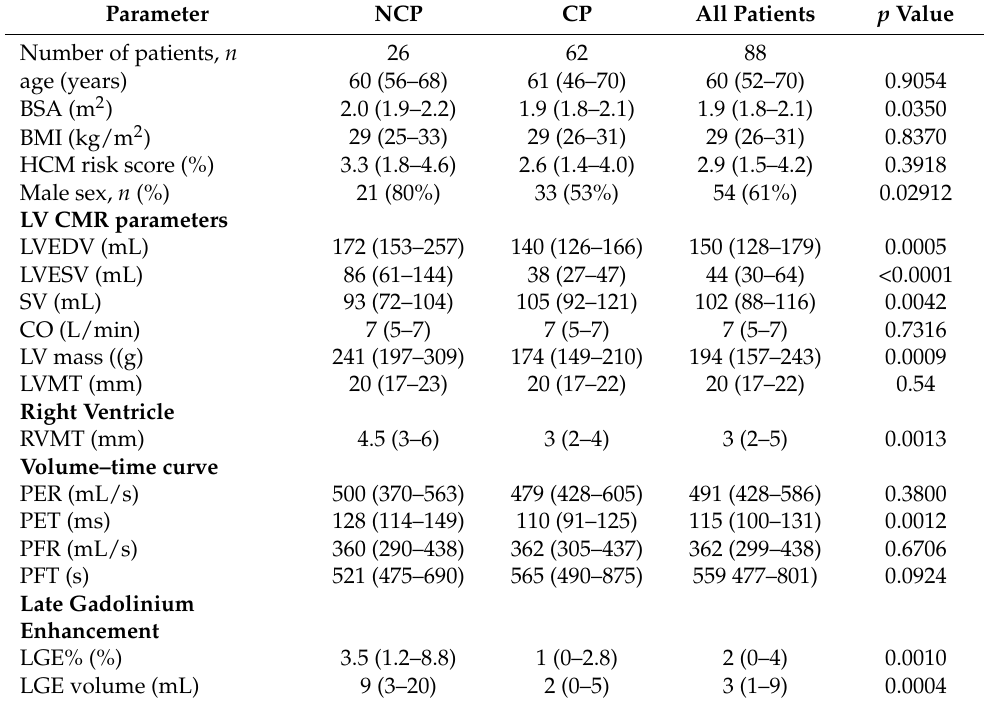
Figure 1. HCM phenotypes and stages in the study group according to Olivotto et al., 2012 [6]. Table 1. Characteristics of the study groups.